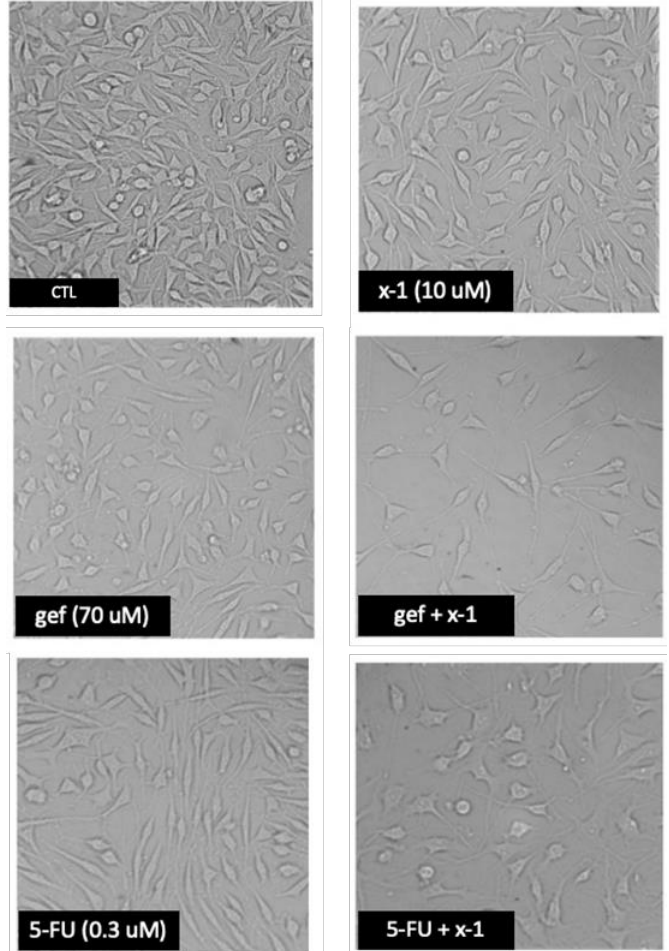
Figure 6. Phase-contrast microscopy images (32x) after MCF-7 cell treatment with the single antineoplastic drugs and synthesized compounds as well as with the combinations of drugs and compounds, for 48 h .